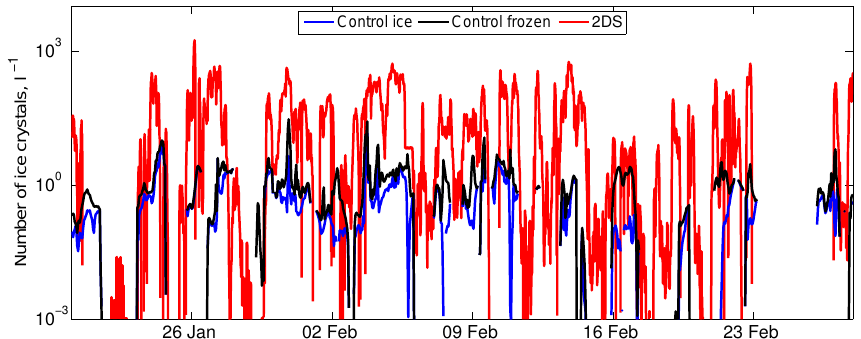
Figure 11. Comparison of measured 2D-S ice number concentration at Jungfraujoch during the INUPIAQ campaign with the ice concentra- tion and the total frozen concentration measured by the control WRF model simulation at